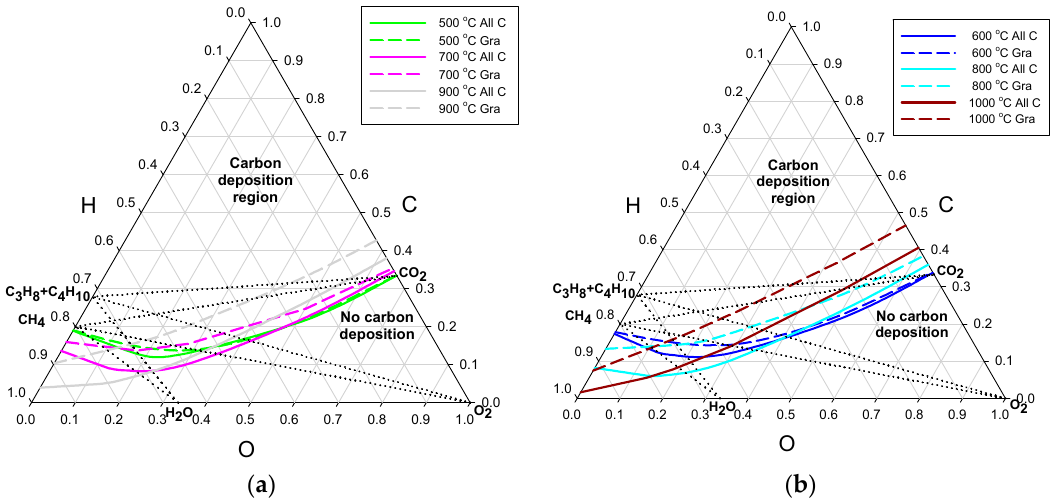
Figure 3. Deposition threshold lines for the process pressure of 30 bar, separately for graphite only (Gra)—broken lines, and all carbon allotropes (All C)—solid lines: ( a ) temperatures of 500, 700, and 900 °C; and ( b ) temperatures of 600, 800, and 1000 °C.